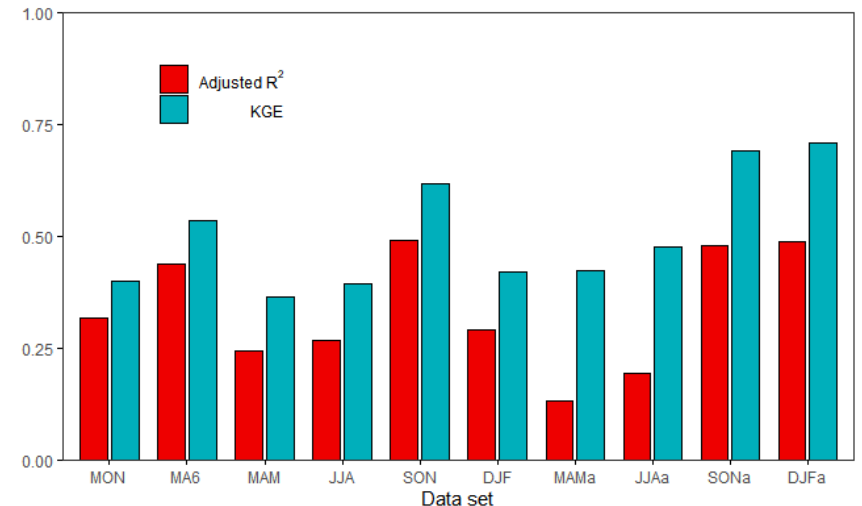
Figure 7. The adjusted R 2 and KGE of Code River’s Q 50 second-order MR models in different temporal data sets.